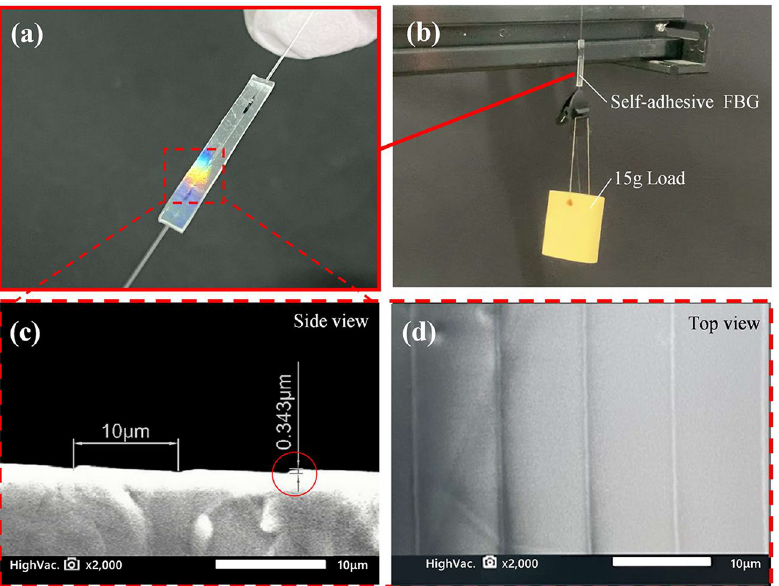
Figure 4. ( a ) Photo of the manufactured sensor sample. ( b ) Self-adhesive FBG with a rubber hanging. (c) SEM image of self-adhesive FBG cross-section. ( d ) SEM image of self-adhesive FBG